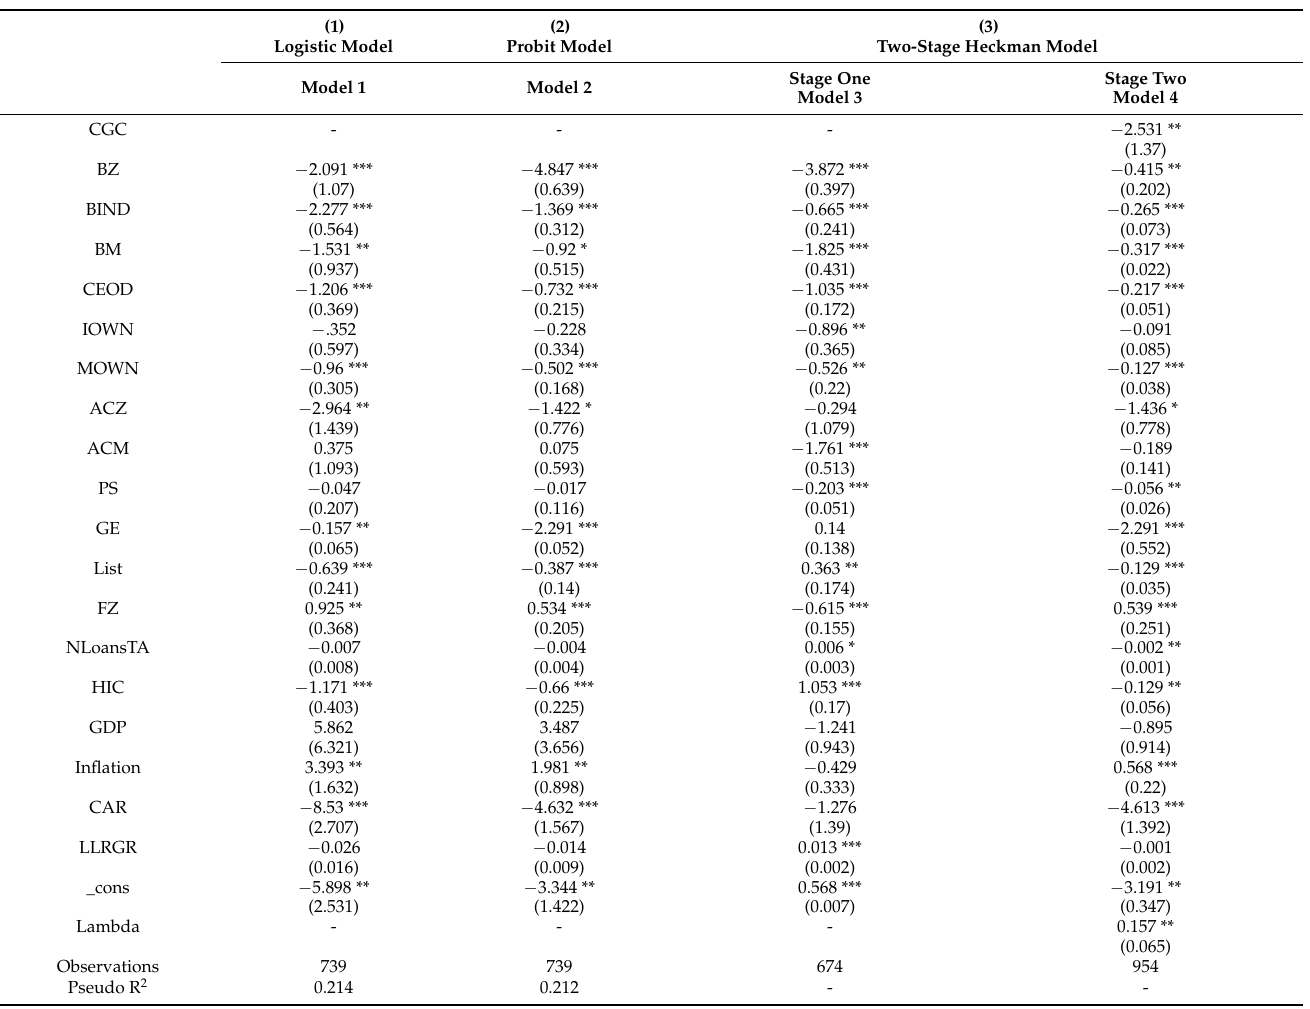
Table 5. The impact of multi-level governance on financial distress predictions in the context of MENA